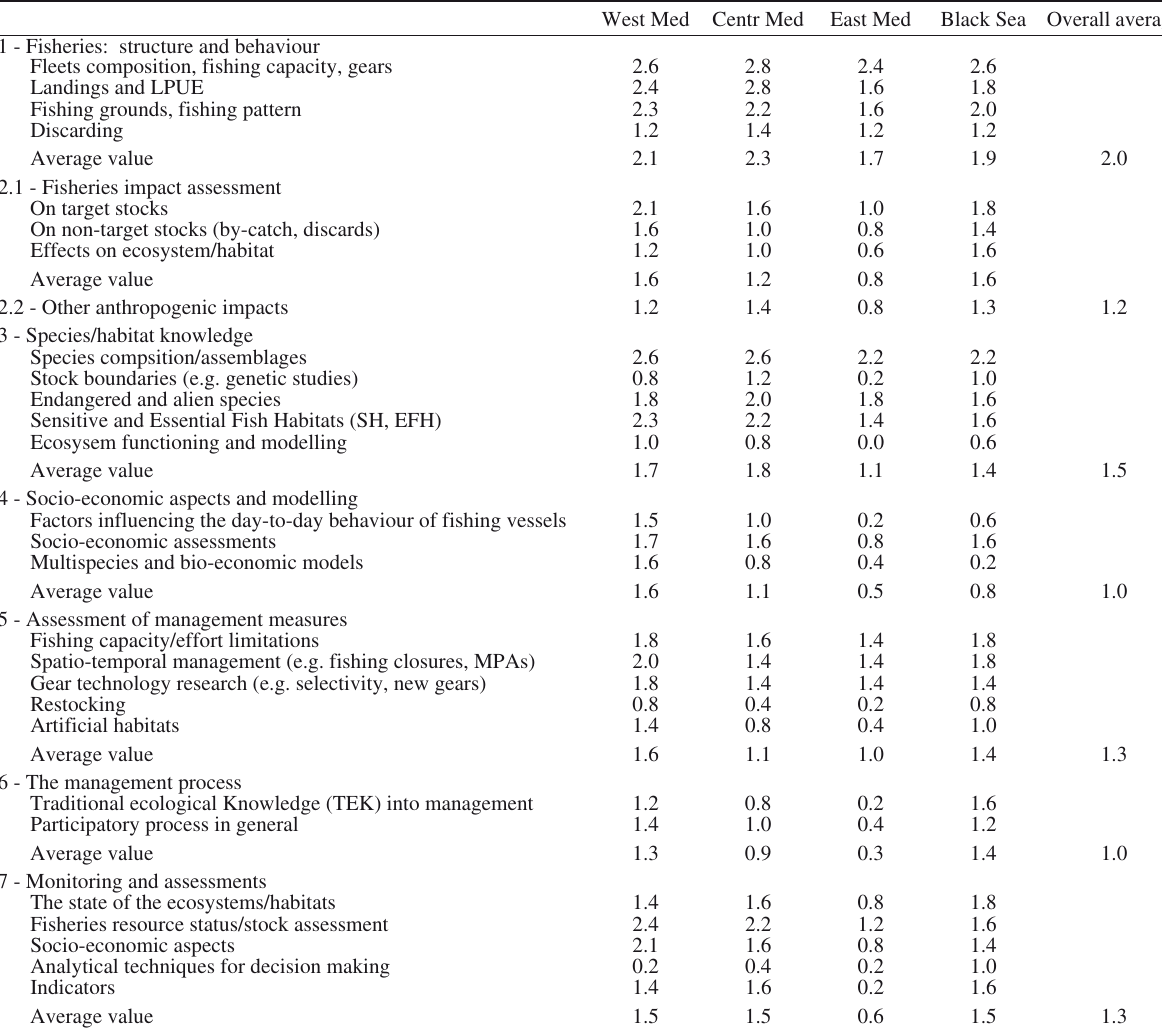
Table 5. – Summary of the results of the expert evaluation on the capacity to address the EAF issues, according to main basins and main topics related to the EAF. Scores range from 0 to 3 (from null to high capacity to address each issue related to the